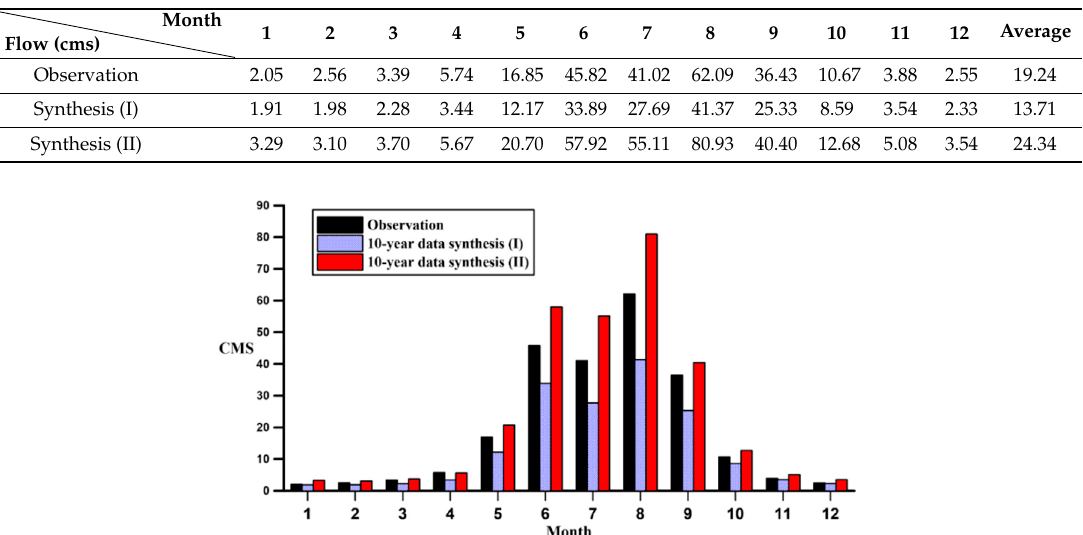
Figure 14. Comparisons of 10-year flow data.